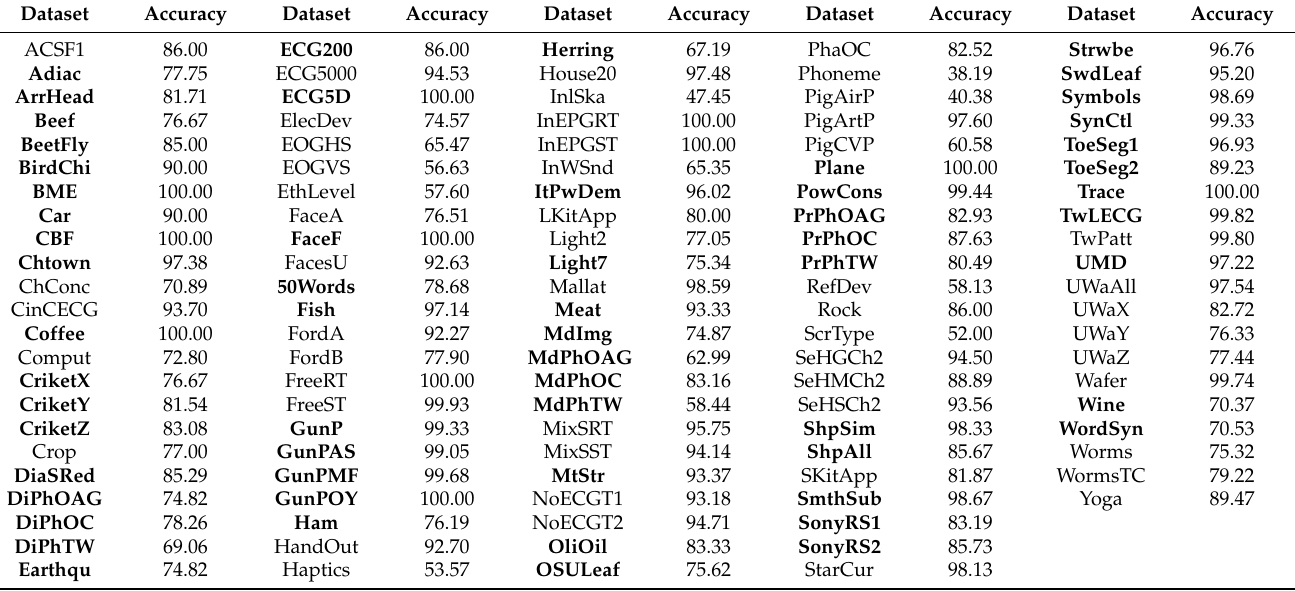
Table 2. Accuracy of RSFCF on 112 UCR time series datasets